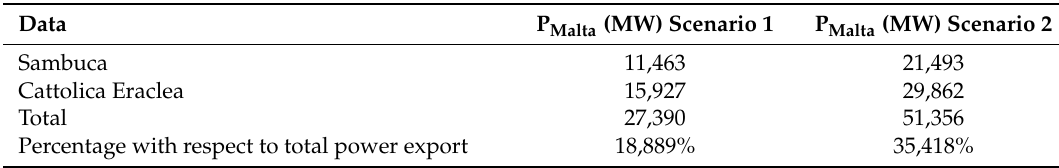
Table 2. Wind farms contributions to power export Sicily to